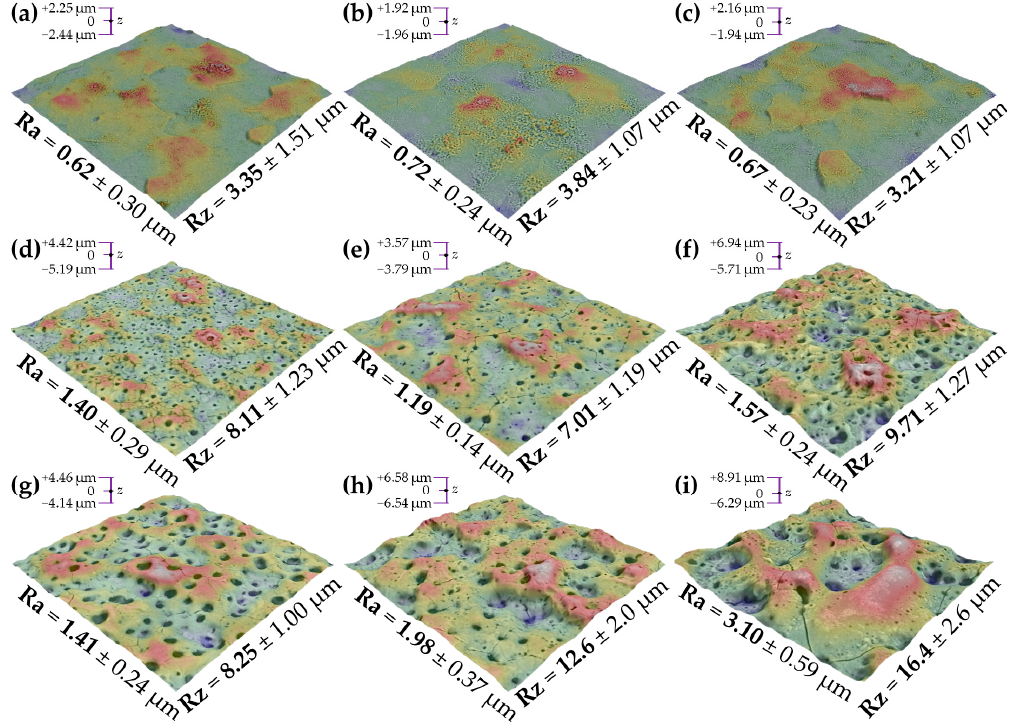
Figure 5. Scanning electron microscope (SEM) surface roughness mapping images of the PEO coatings formed on zirconium up to 200 ( a – c ), 300 ( d – f ), and 400 V ( g – i ) in the Ca1P2 ( a , d , i ), Ca2P1 ( b , e , h ), and (CaMg)2P1 ( c , f , i ) solutions. The images have dimensions of 90 µm × 90 µm, while the Ra and Rz values were calculated from the profiles taken from other images having the size of 270 µm × 270 µm.